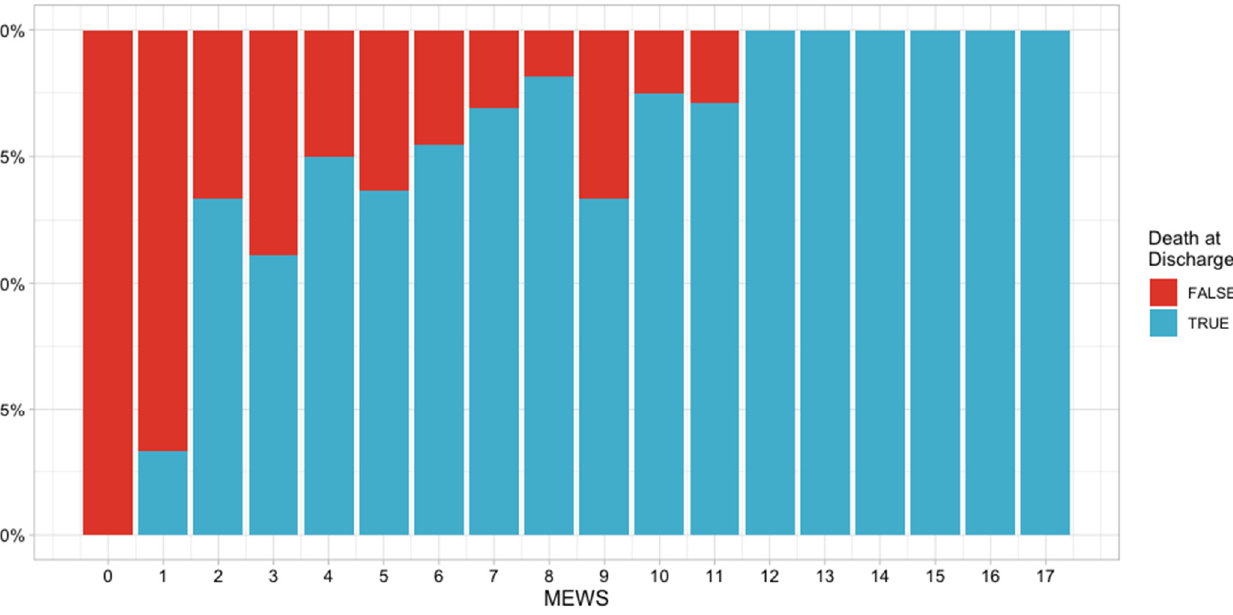
Figure 2. Frequency of death by MEWS